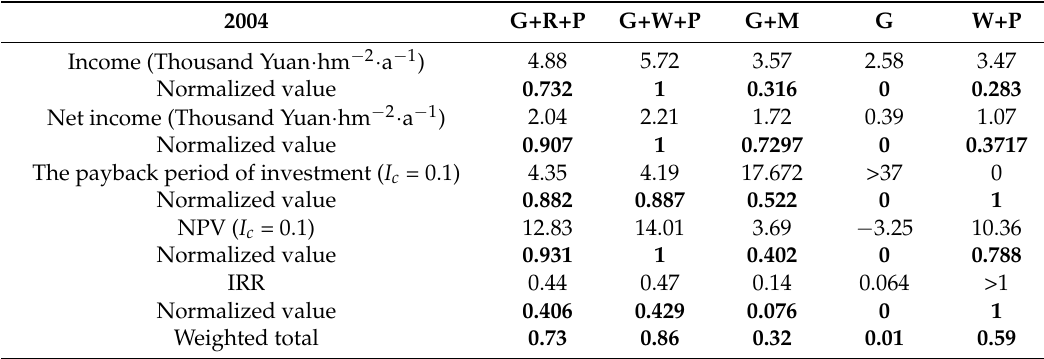
Table A2. Economic indicator values from three mixed Ginkgo systems, pure Ginkgo (G), and a cropping system (W+P), in 2004.